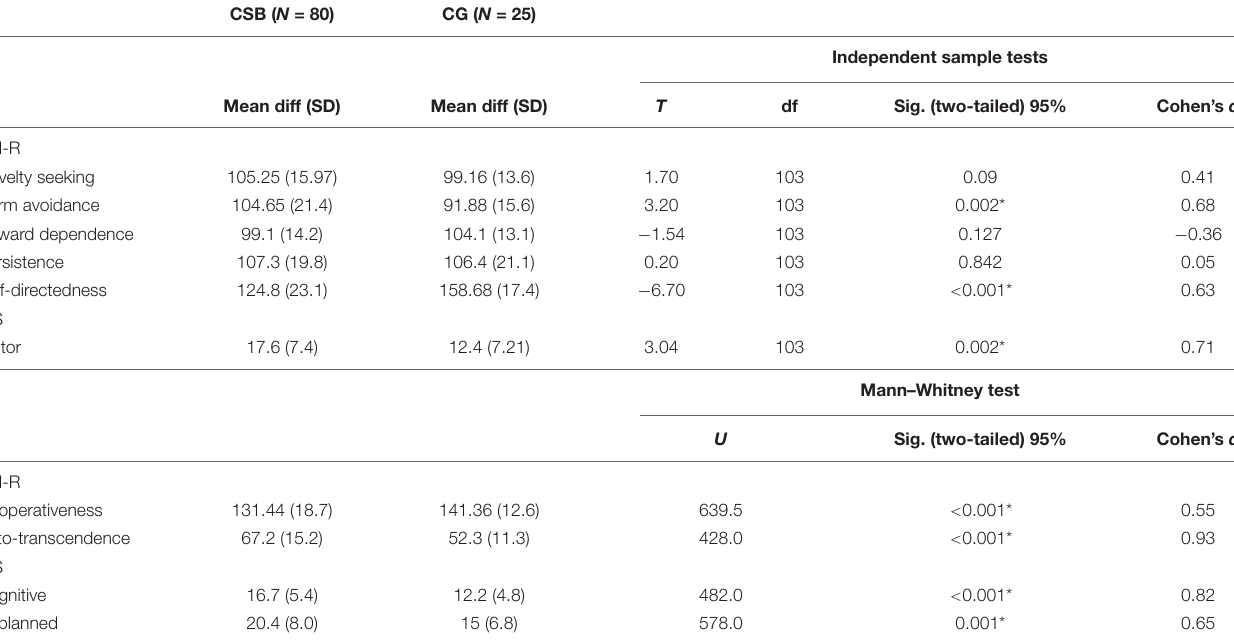
TABLE 3 | Comparison between experimental and healthy control groups of personality outcomes.